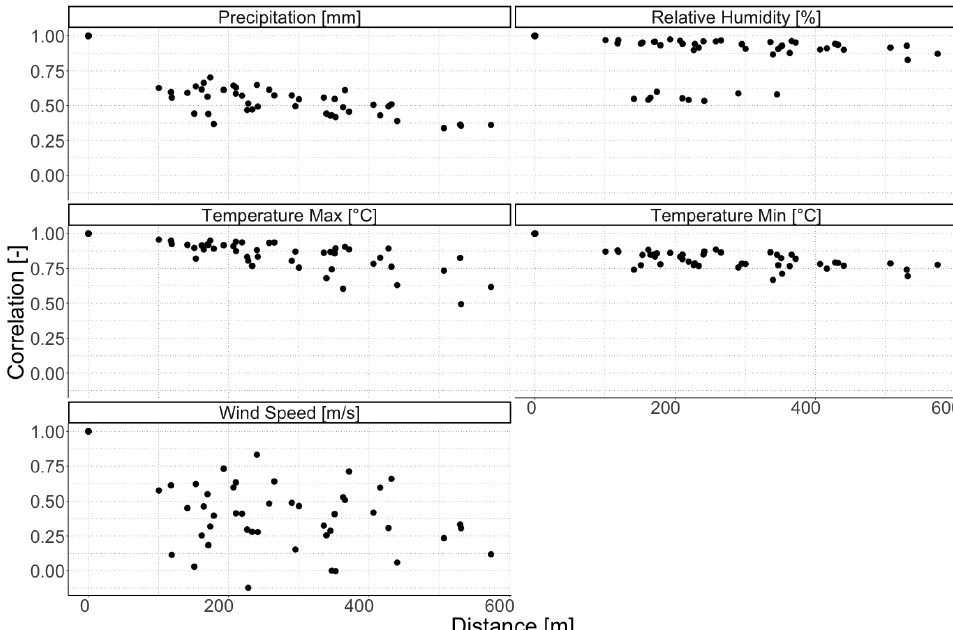
Figure 5. Distance-correlation relationship for examined TAHMO station in Burkina Faso and the variables maximum temperature ( ◦ C), minimum temperature ( ◦ C), precipitation (mm), relative humidity (%) and wind speed (m/s). A decrease in correlation with increasing distance becomes apparent within each variable.